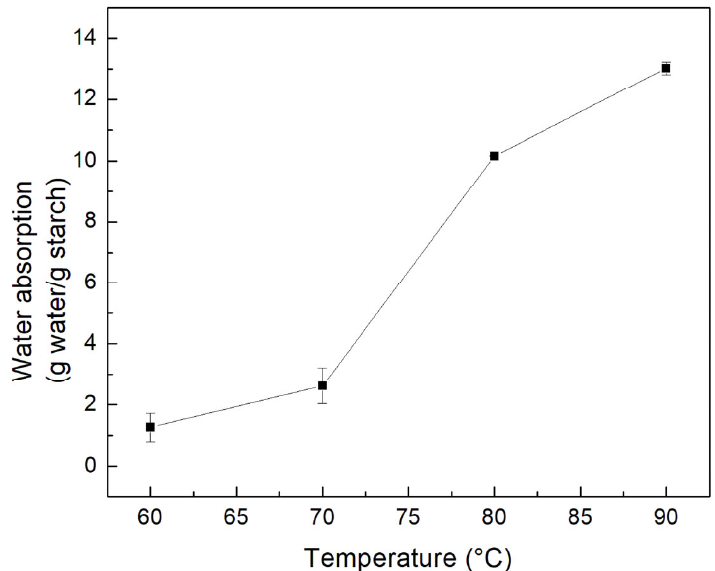
Figure 4. Water absorption of colok starch at different temperatures. Table 4. Mean ± standard deviation of the physicochemical characteristics of Talisia floresii Standl native